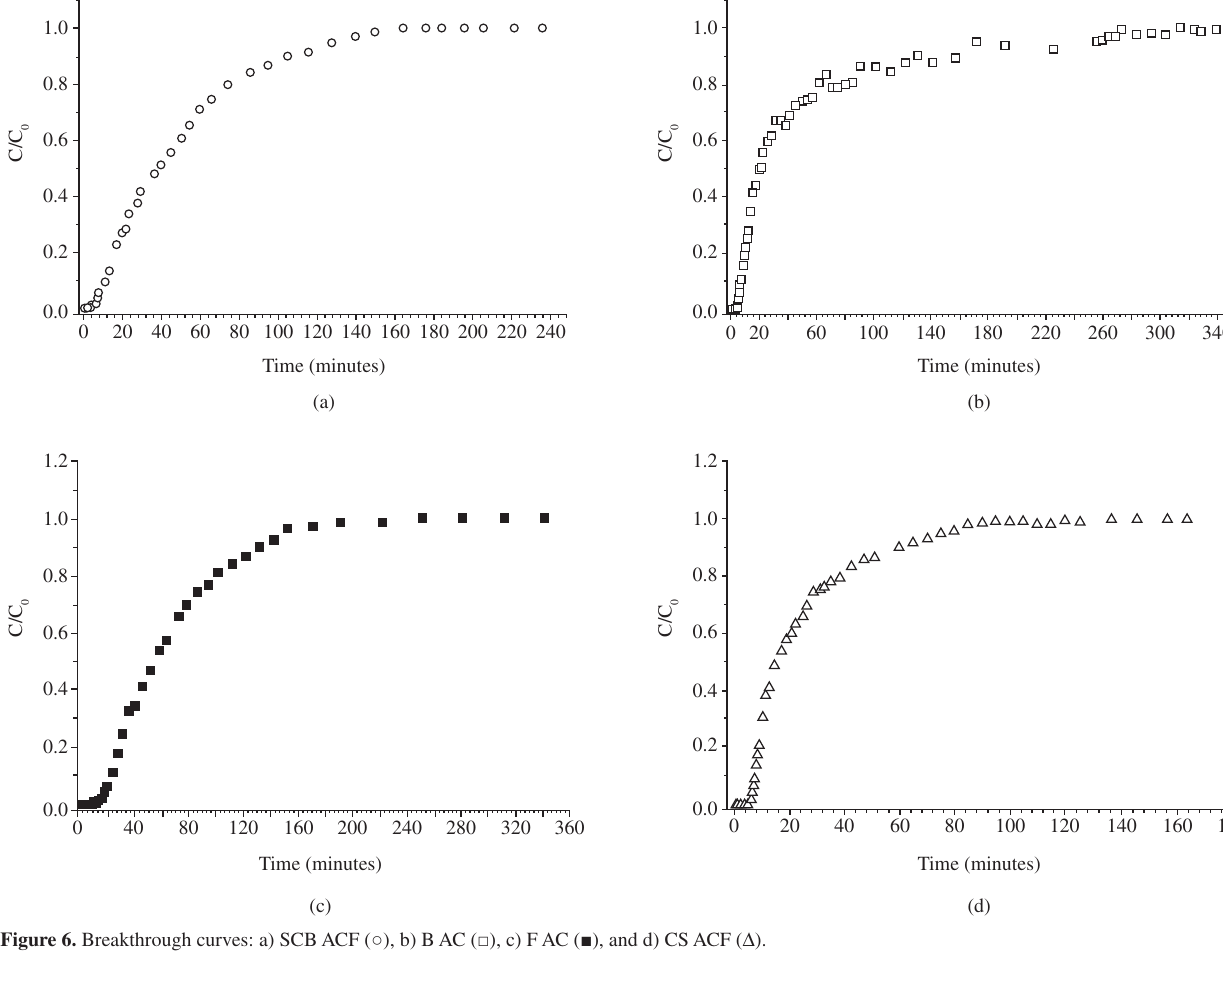
Table 5. Parameters dynamic adsorption of the [D-Leucine 1 ]MCYST-LR on fixed-bed.